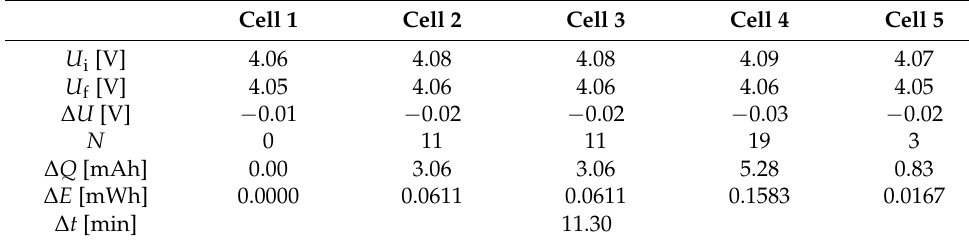
Table 3. Balance system configuration data.